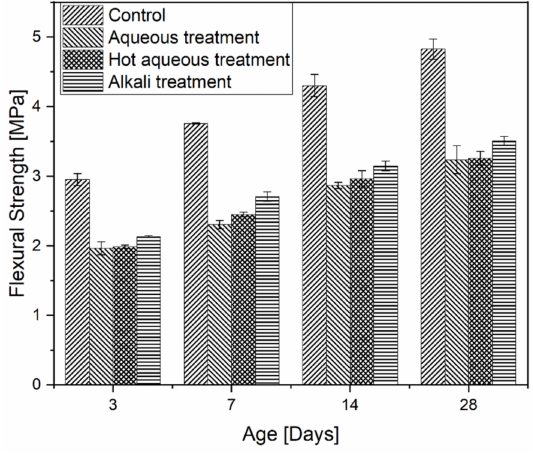
Figure 7. Flexural strength of BSC3 with different